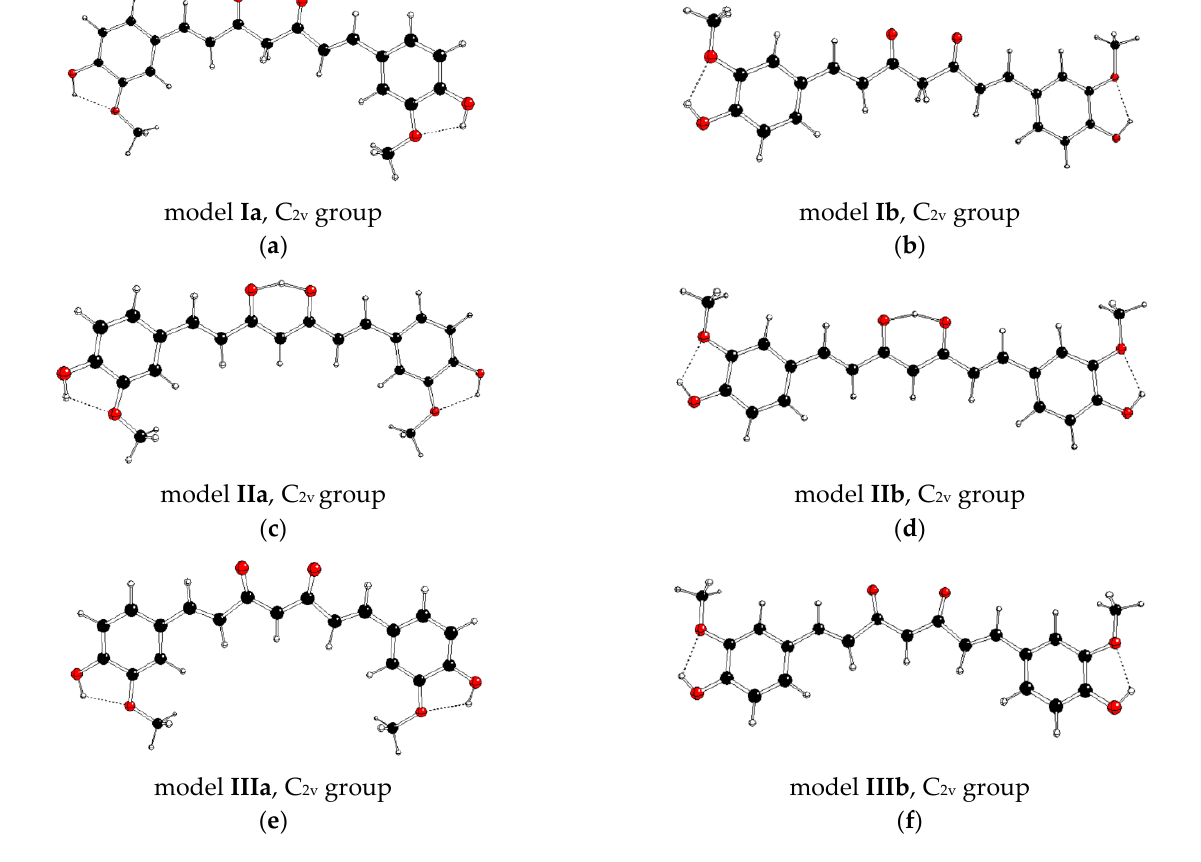
Figure 1. M062X/cc-pVDZ optimized curcumin structures of C 2v group of the neutral diketo forms ( a , b ), neutral enol forms ( c , d ), and anionic enolate forms ( e , f ) (C—black, O—red, H—white).